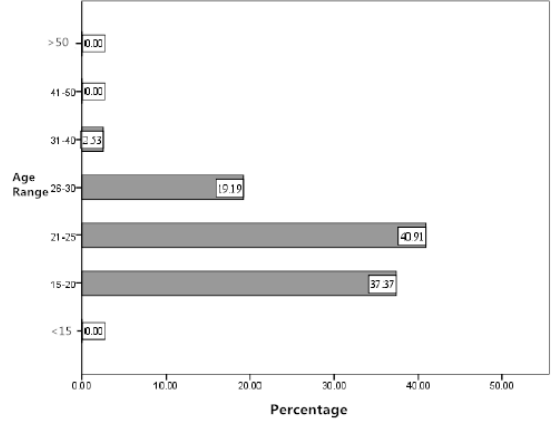
Figure 3: Age distribution map